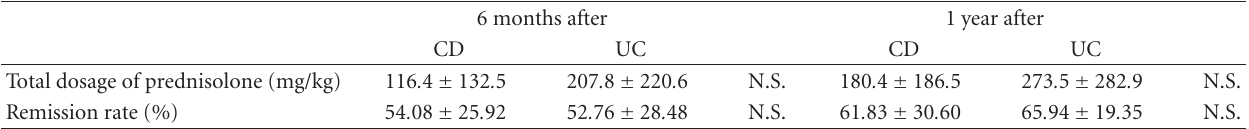
Table 3: Comparison of total dose of PSL and remission rates between children with CD and those with UC 6 months and 1 year after the start of treatment (mean ±